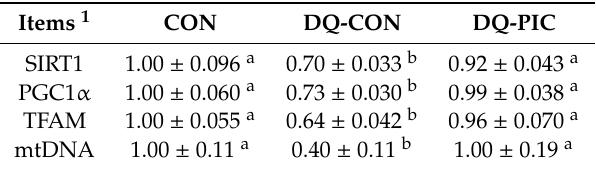
Table 8. Effects of piceatannol supplementation on expression levels of genes related to mitochondrial biosynthesis and function in the liver of diquat-induced piglets.